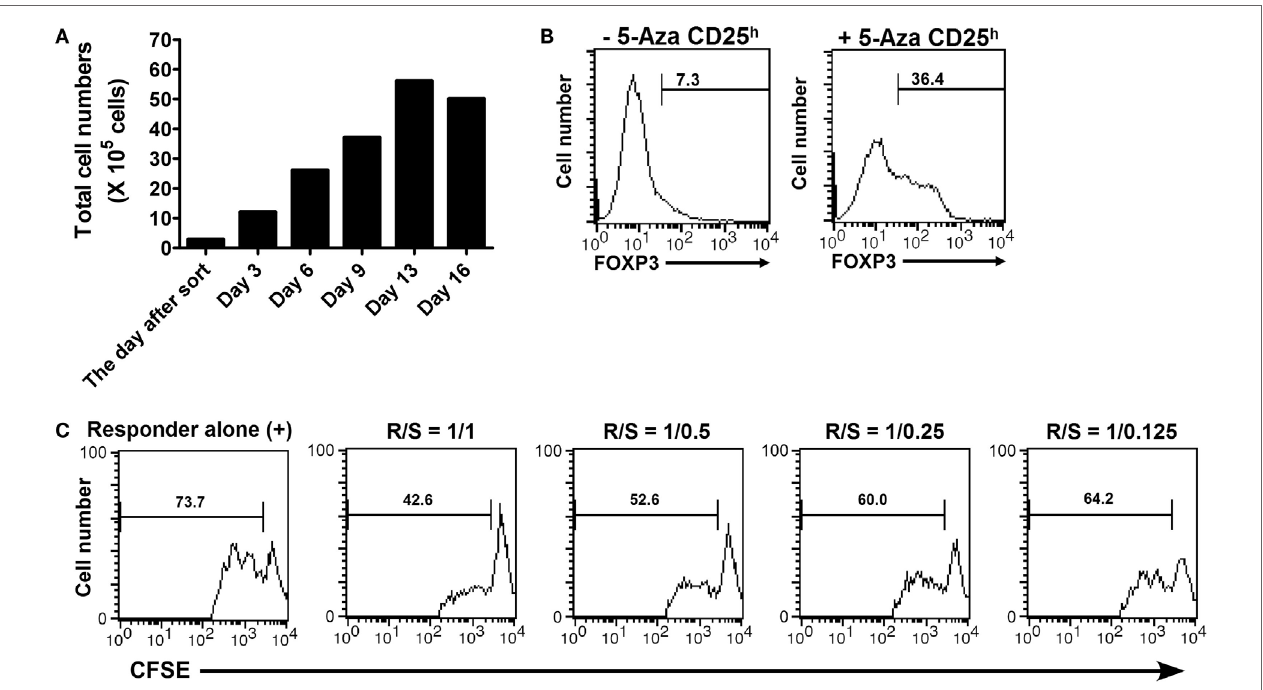
FigUre 5 | 5-aza-treated cD4 + cD25 h T cells proliferated without Tcr stimulation, but with only il-2 supplementation and still maintained FOXP3 expression and their suppressive function after expansion . The sorted 5-Aza-treated CD4 + CD25 h T cells were cultured with recombinant IL-2 (100 U/ml). The culture medium supplied with IL-2 was refreshed every 2 days for 16 days. (a) The cell numbers were determined by trypan blue exclusion during the refreshment of the culture medium. (B) FOXP3 expression in the expanded CD4 + CD25 h T cells was examined by intracellular staining followed by flow cytometric analysis. FOXP3 dim cells were excluded. (c) The expanded 5-Aza-treated CD4 + CD25 h T cells were cocultured with CFSE-labeled responder for 3 days. The results were analyzed by FACSCalibur. One representative result of five experiments is